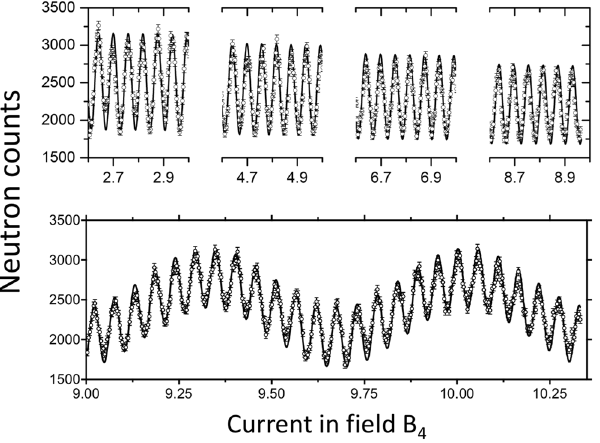
Figure 9. The fringes measured when the two arms are balanced (top) and unbalanced (bottom). Dots are measured data and solid curves are